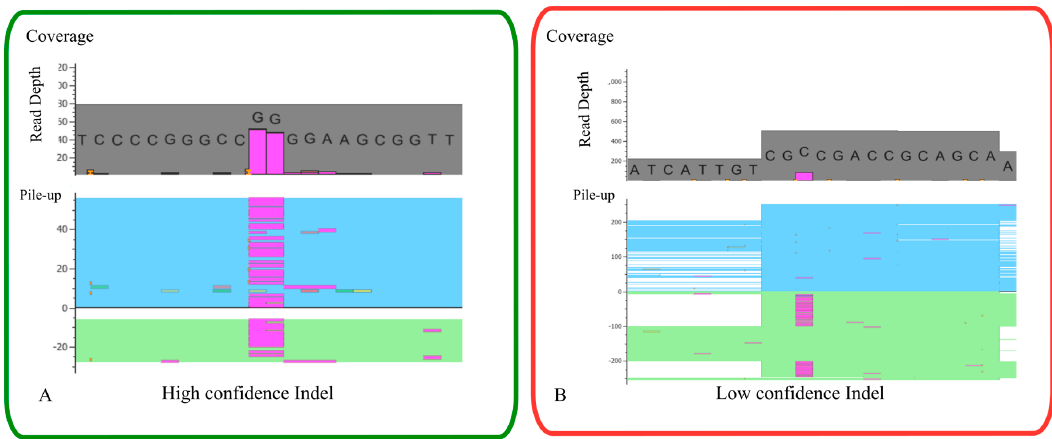
Figure 7. BAM (binary alignment map) file visual inspection. Two examples of situations that may be observed through this inspection. ( A ) Demonstrates a case of a true-positive INDEL, confirmed by Sanger sequencing. In contrast, ( B ) shows a clear example of a false-positive result, where the variant is present in only reverse reads, as later demonstrated by Sanger sequencing it is a technical artifact and should be excluded from further analysis.